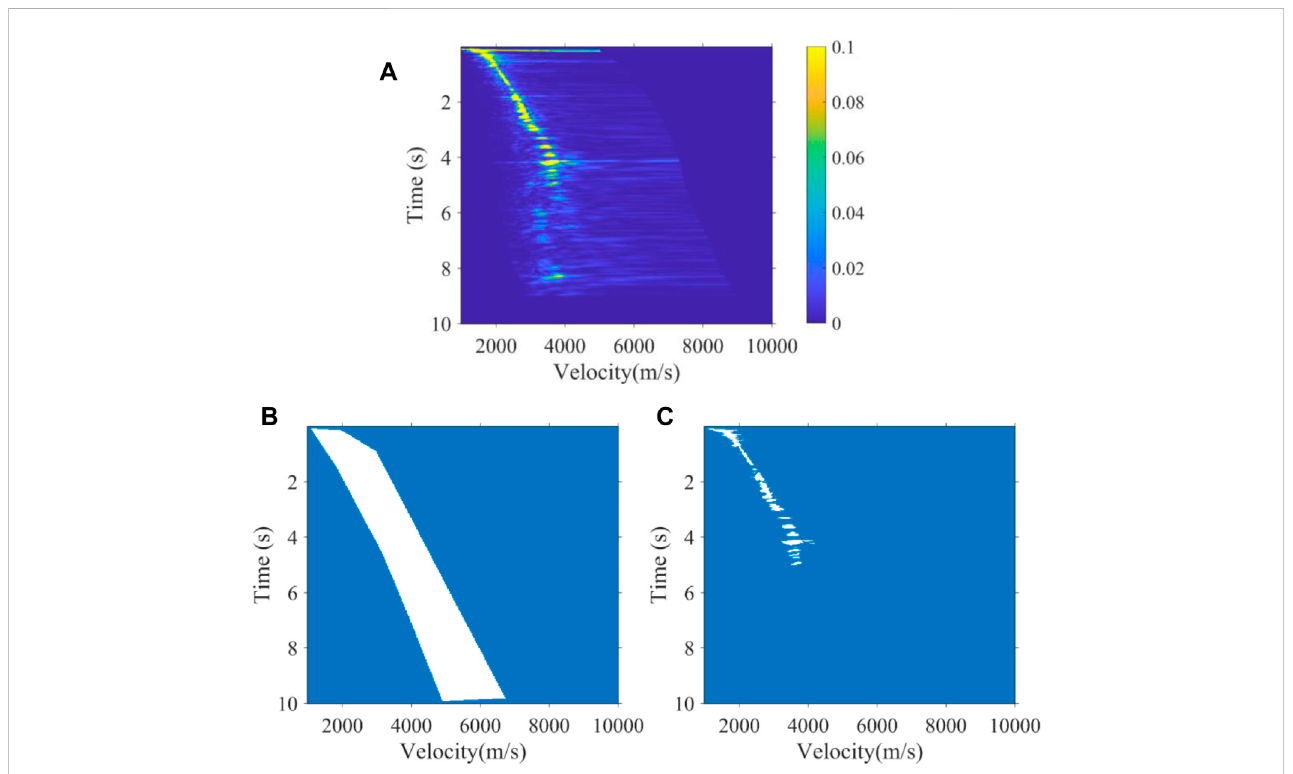
FIGURE 3 (A) 3900th velocity spectrum with multiple developments in 6 – 9 s of real data, (B) expert experience constraint band, and (C) segmentation